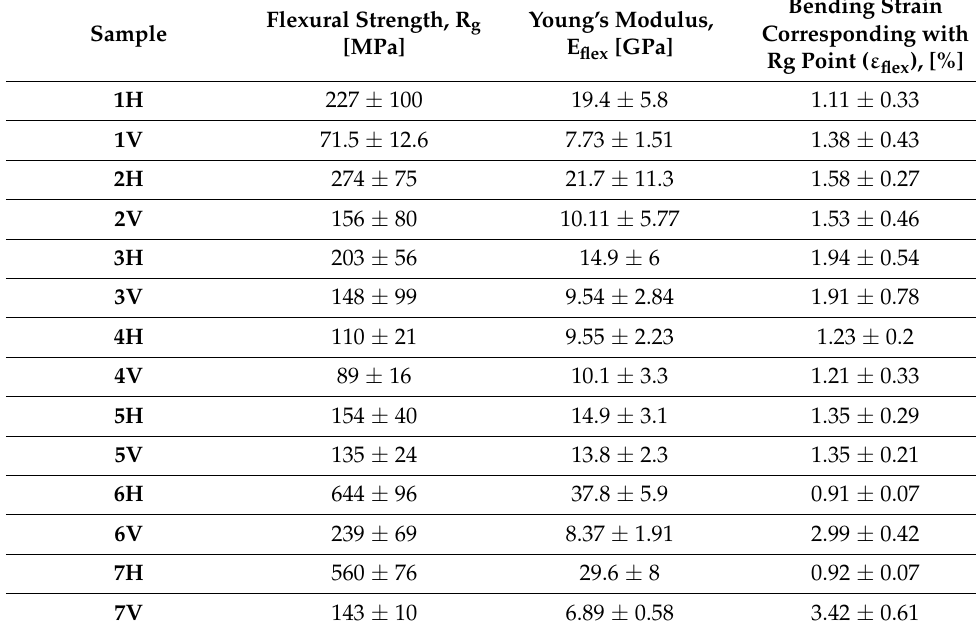
Table 2. Results of three-point bending tests—designations of the series 1–7—see Table 1; H— bending direction along the fiber placement direction, V—bending direction perpendicular to the fiber placement